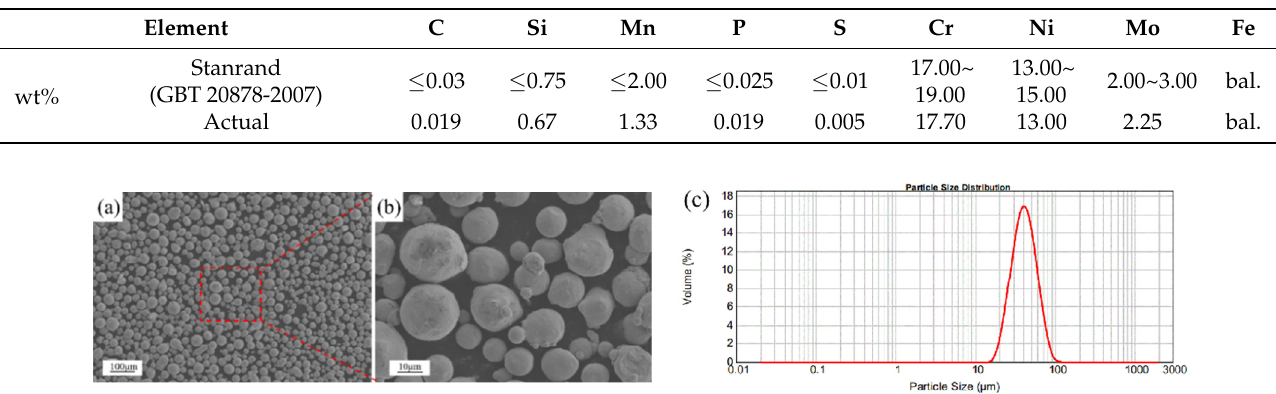
Figure 1. ( a ) Morphology of 316 L stainless steel powder; ( b ) particle size distribution of 316 L stainless steel power; ( c ) Powder particle diameter. Table 1. Chemical composition of as-received 316 L stainless steel powder (weight percent). Element